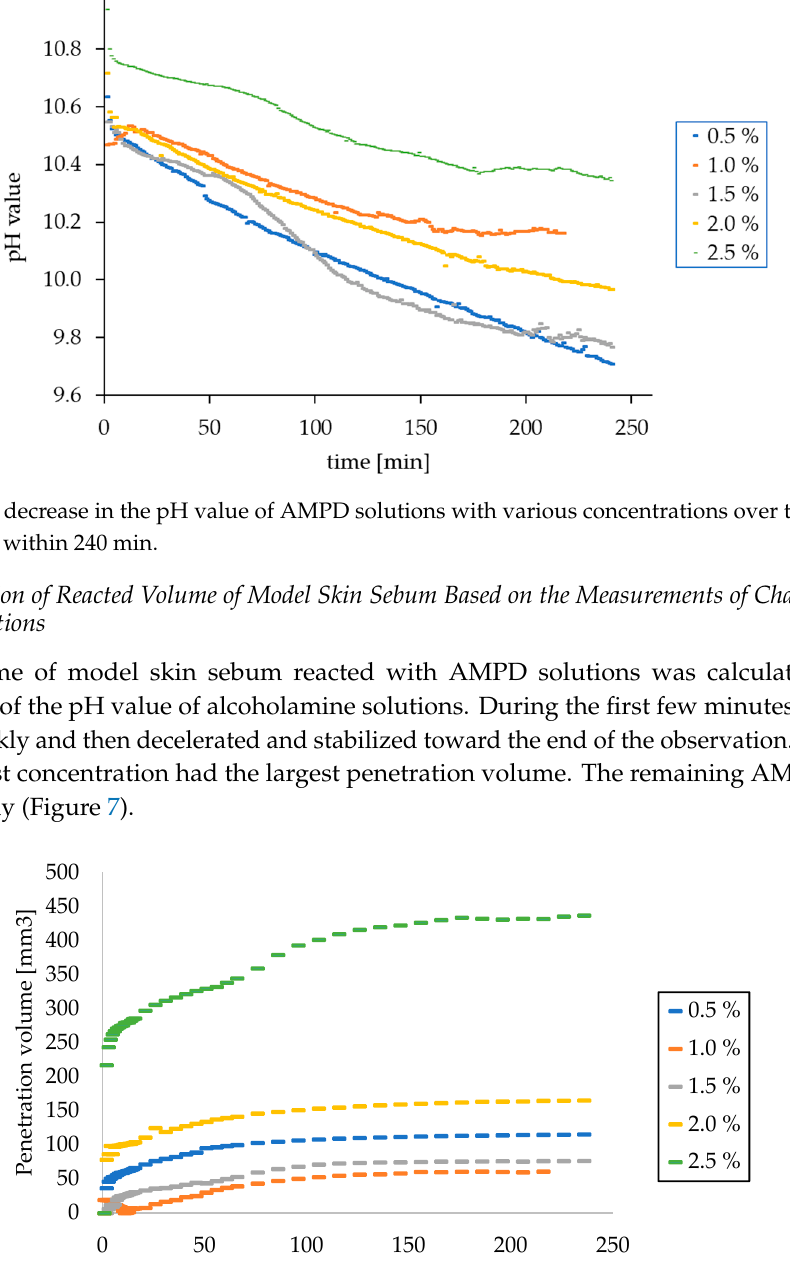
Figure 7. The reacted volume of the model skin sebum was determined based on changes in the pH of AMPD solutions.